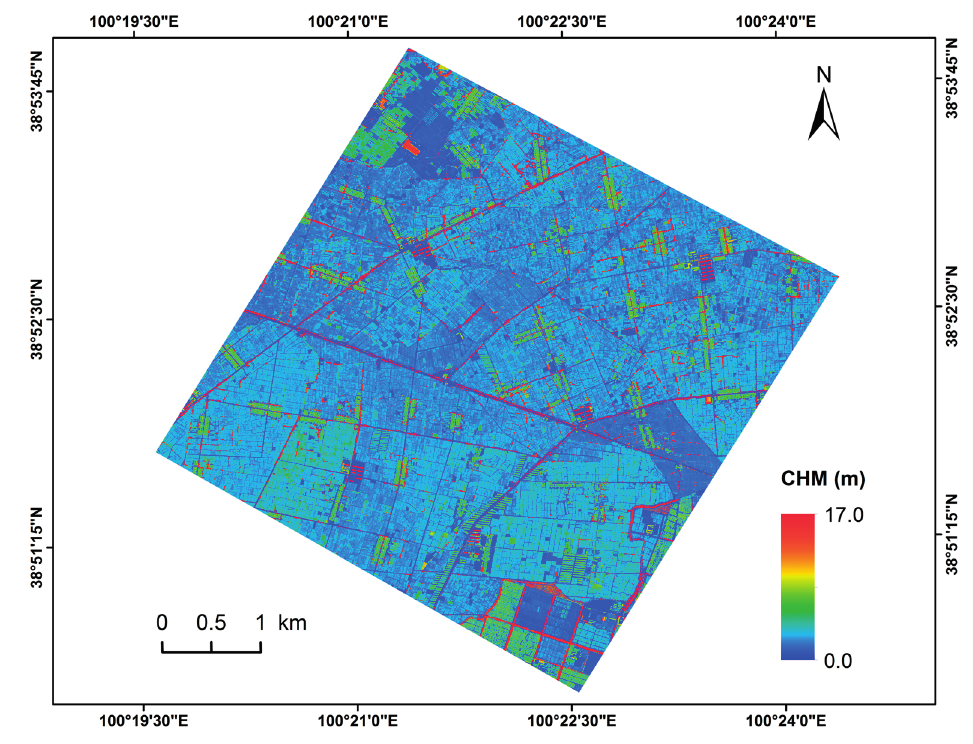
Figure 4. CHM map of the study